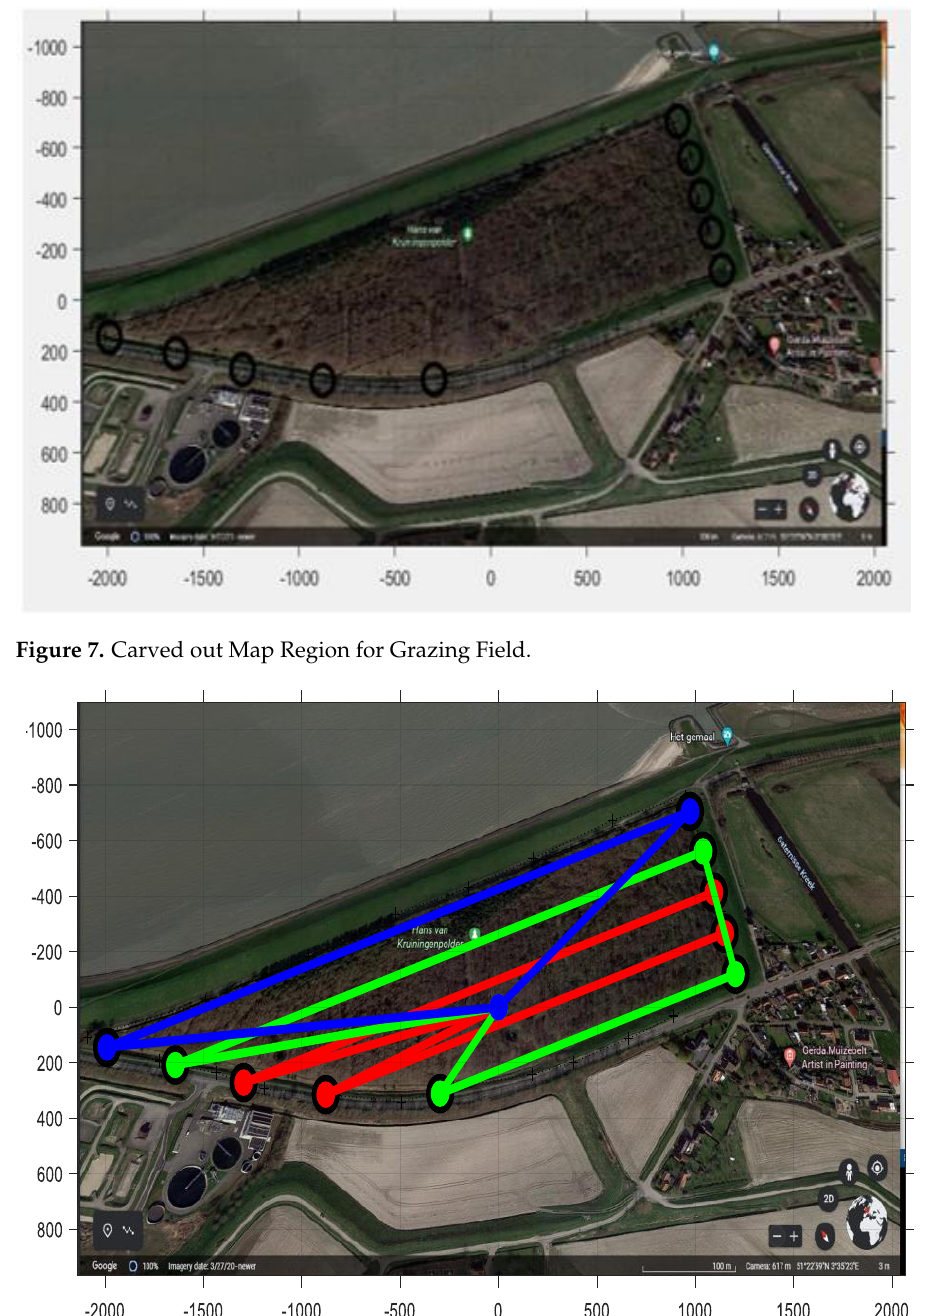
Figure 6. Processing Map Region for Grazing Field.